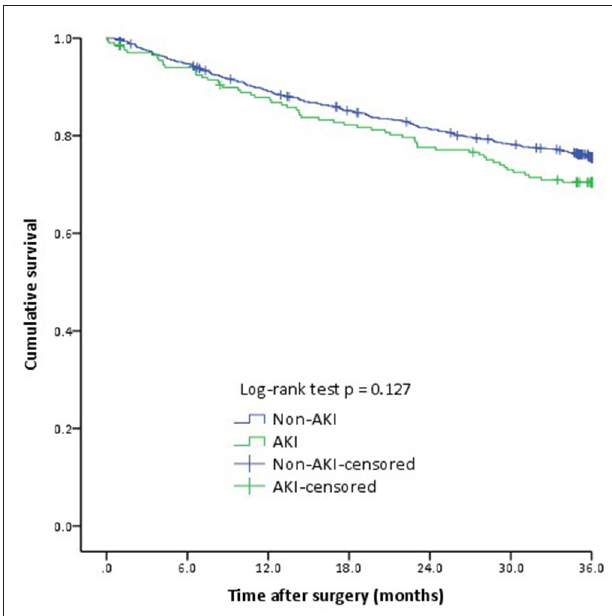
FIGURE 2 | The Kaplan-Meier analysis of 3-year mortality between two groups. Cumulative 3-year mortality was comparable between two groups (Log-rank test P = 0.13). AKI, Acute kidney